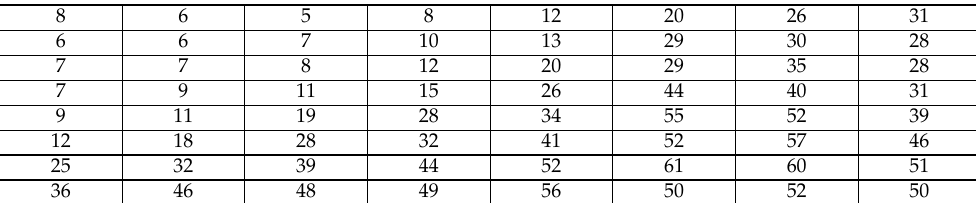
Figure A1. AC Huffman table. The wider range of AC coefficients requires more code-words. Table A2. Quantization table. The corresponding JPEG quality factor is 75%.